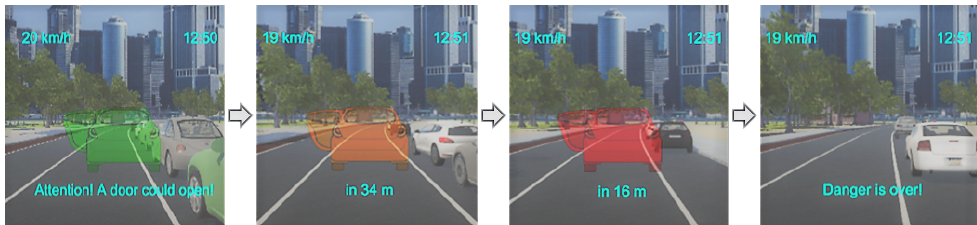
Figure 1. The incoming message states “Attention! A door could open!” and a transparent, green icon of a vehicle with an opened door is displayed ( m 1 ), then changing to an orange icon with text indicating the distance ( m 2 ). In the next message ( m 3 ), the icon changes to red and, at last, a cancellation message ( m 4 ) notifies the cyclist that the “Danger is over!” . The notifications were displayed in a screen-fixed